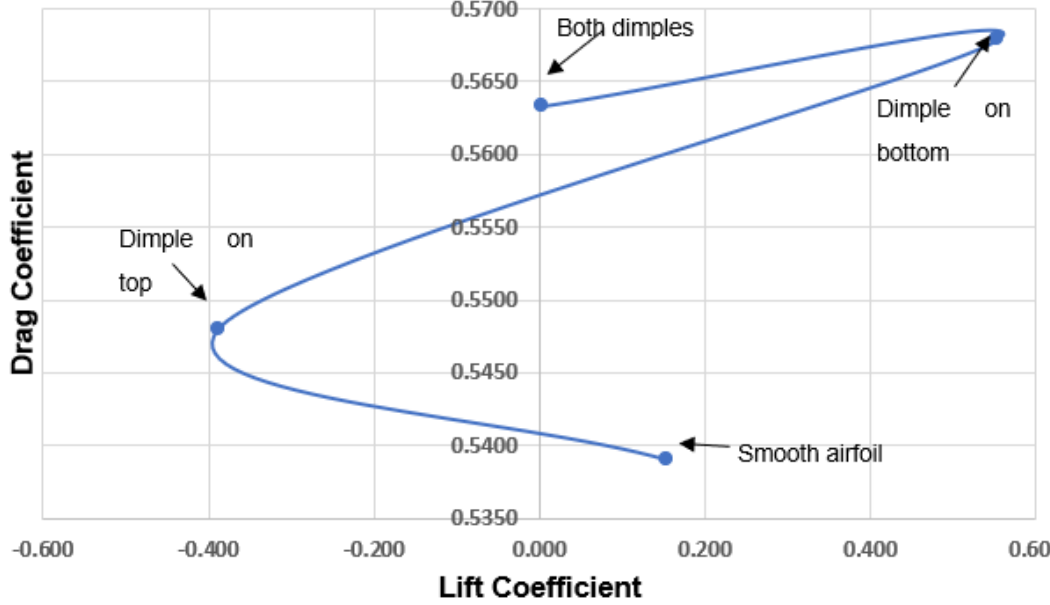
Figure 15. The relationship between lift and drag coefficients on an aerofoil with an ellipse-shaped dimple.